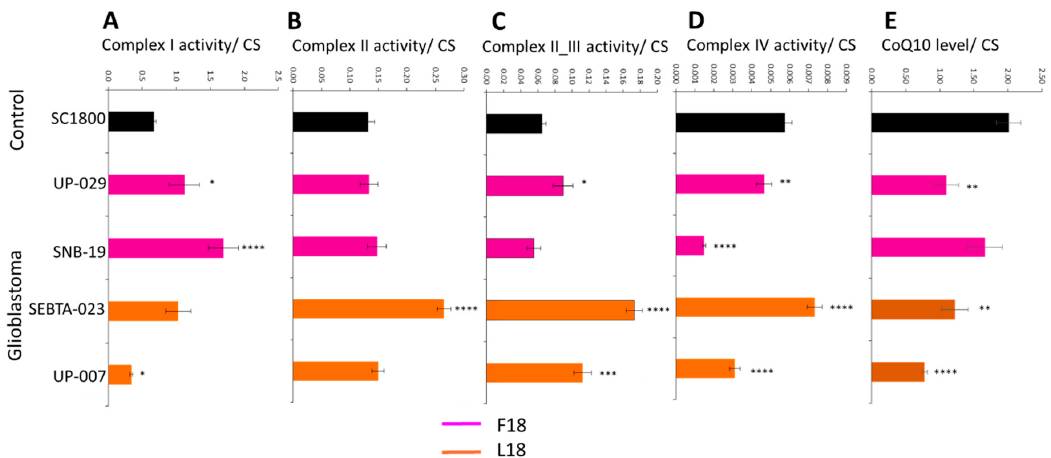
Figure 1. Mitochondrial respiratory chain complex activities and CoQ10 levels in primary adult glioblastoma and normal adult astrocyte cell cultures. ( A ) complex I (NADH-ubiquinone oxidoreductase), ( B ) complex II (succinate-ubiquinone oxidoreductase), ( C ) complex II_III (succinate-dehydrogenase cytochrome c reductase), ( D ) complex IV (cytochrome c oxidase) activity were measured spectrophotometrically, and ( E ) CoQ10 levels were measured via reverse phase HPLC. Data are expressed as mean respiratory chain complex activity or CoQ10 level relative to citrate synthase (CS) activity ± standard error mean (SEM). For respiratory chain complex activities, all cell cultures were measured in triplicate on three independent occasions to give n = 9 in each case, and for CoQ10 levels, all cell cultures were measured in triplicate. Asterisks highlight statistically significant differences between adult glioblastoma that are either carriers of F18L (SEBTA-023 and UP-007, orange) or non-carriers (UP-029 and SNB-19, magenta) relative to adult astrocyte (SC1800, black) cell cultures (where *, **, ***, and **** is p < 0.05, 0.005, 0.0005, and 0.00005, respectively) .